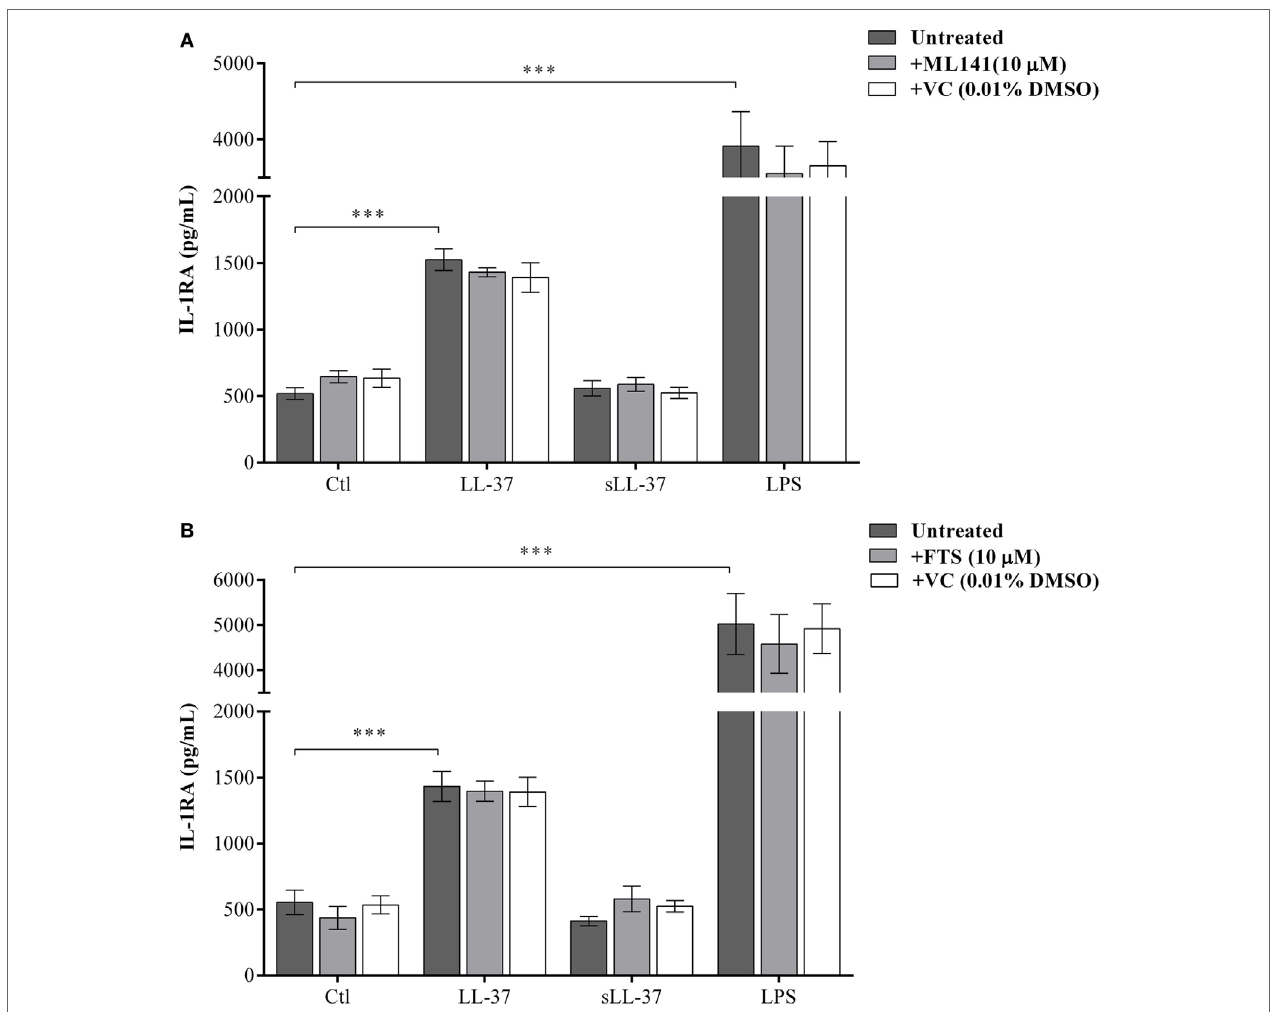
FigUre 2 | LL-37-induced anti-inflammatory cytokine IL-1RA production is independent of Rho and Ras GTPase activity. Macrophage-like THP-1 cells were pre-incubated with either (a) the Cdc42/Rac1 inhibitor ML141 (10 µM) or (B) Ras inhibitor FTS (10 µM), for 1 h prior to stimulation with either LL-37 (5 µM), sLL-37 (5 µM), lipopolysaccharide (10 ng/ml), or 0.01% DMSO as vehicle control (VC). Tissue culture supernatants were monitored by ELISA for the production of the anti-inflammatory cytokine IL-1RA after 48 h. Results shown as mean ± SE of eight independent experiments ( n = 8). Analysis of variance with Bonferroni’s post hoc test was used for statistical analyses (*** p <